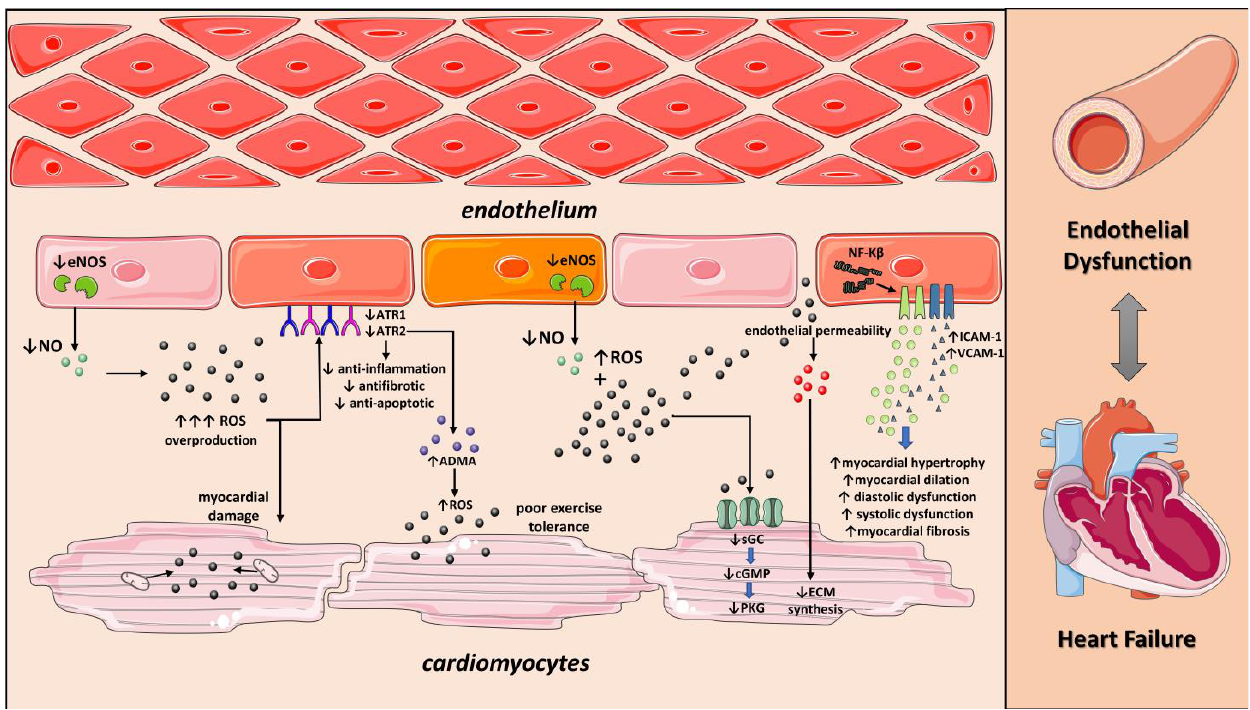
Figure 1. Role of Endothelial dysfunction on Heart failure. Endothelial dysfunction induces im- paired NO production and ROS overproduction. Excessive ROS increases ADMA levels resulting in decreased exercise tolerance. Moreover, ROS production at mitochondria and the presence of dysfunctional antioxidant system cause hypoxia and accelerate myocardial damage. Deterioration of NO-cGMP-PKG pathway increases diastolic dysfunction, myocardial fibrosis, and myocardial hypertrophy. NO: nitric oxide; ROS: reactive oxygen species; eNOS: Endothelial nitric oxide synthase; ADMA: Asymmetric Dimethylarginine; ATR1: Angiotensin II receptor type 1; ATR2: Angiotensin II receptor type 2; NF-K β : Nuclear factor kappa beta; ICAM-1: Intercellular Adhesion Molecule 1; VCAM-1: vascular cell adhesion molecule 1; cGMP: Cyclic guanosine monophosphate; sGC: soluble guanylate cyclase; PKG: protein kinase G. Parts of the figure were drawn by using pictures from Servier Medical Art. Servier Medical Art by Servier is licensed under a Creative Commons Attribution 3.0 Unported License (https://creativecommons.org/licenses/by/3.0/ accessed on 23 of December